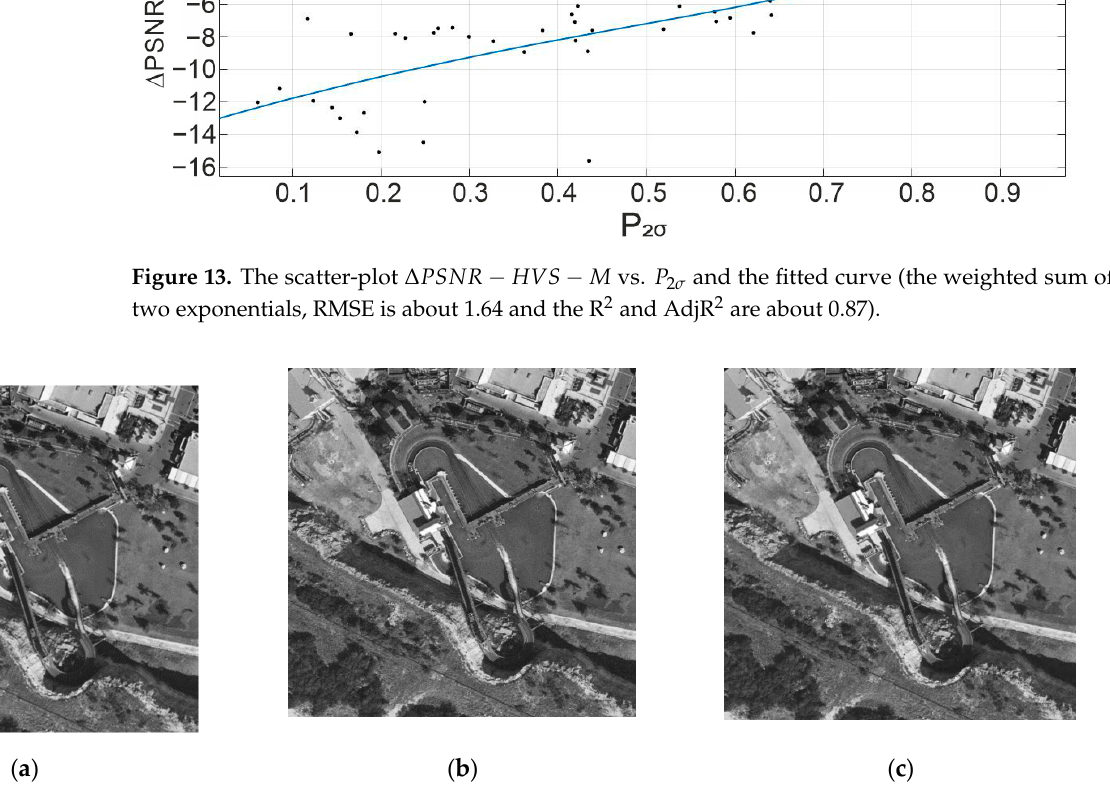
Figure 14. The noise-free test image Fr03 ( a ), this image corrupted by AWGN with noise variance equal to 25 ( b ) and the image compressed using Q OOP = 29 ( c ), CR = 5.84.